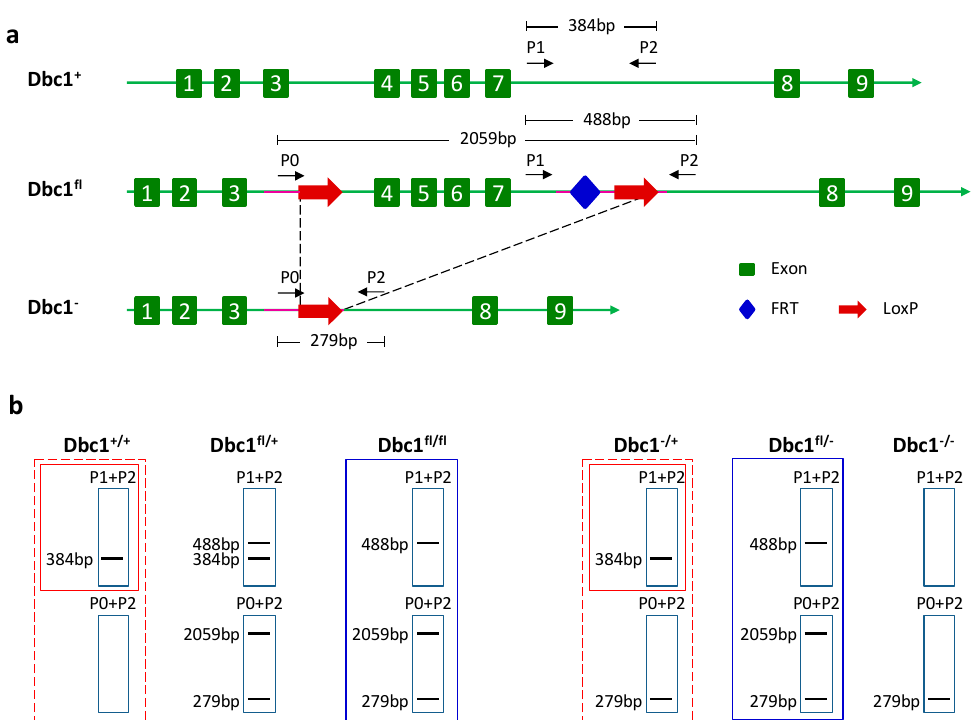
Figure 1. The generation and genotype strategy of the conditional Dbc1 allele. ( a ) Targeting strategy of the conditional Dbc1 allele. Shown from top to bottom (i) the Dbc1 locus with the exons, the site of the primer 1 (P1) and primer 2 (P2); (ii) the targeted locus with the site of the primer 0 (P0), LoxP and FRT sites; (iii) the locus after Cre-mediated deletion of the LoxP sites. ( b ) The genotype strategy of different Dbc1 alleles. The figure shows the predicted site and number of fragments of the mice with different Dbc1 alleles using the indicated primer.